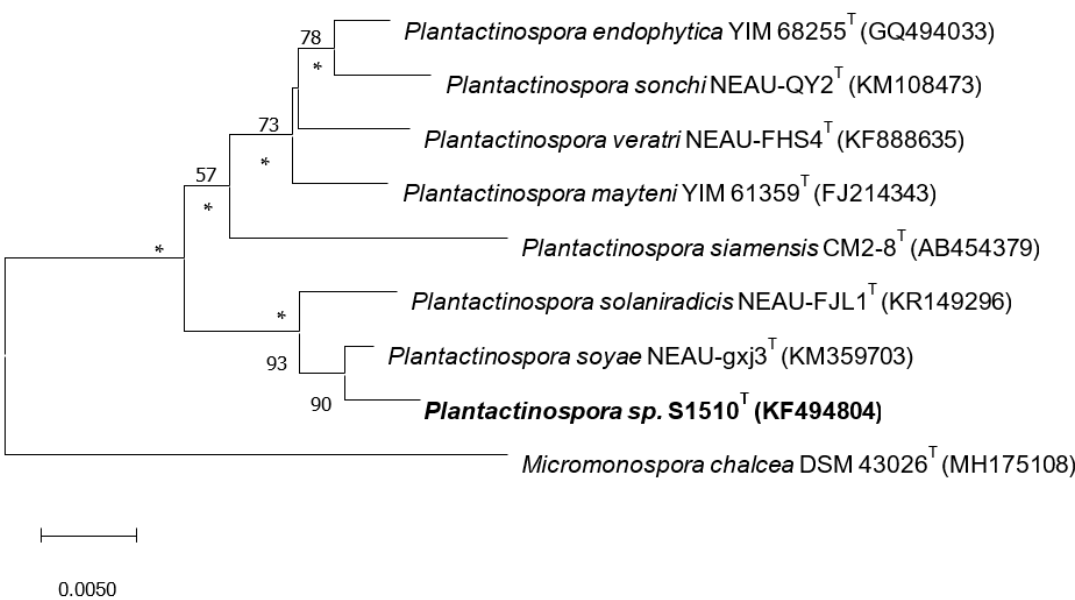
Figure 1. Neighbour-joining phylogenetic tree, based on the 16S rRNA gene sequences of strain S1510 T and members of the genus Plantactinospora . Asterisks indicate conserved nodes for the maximum likelihood and the maximum parsimony trees. Bootstrap of 1000 were used and results are indicated at nodes. Micromonospora chalcea DSM 43026 T was used as the outgroup.